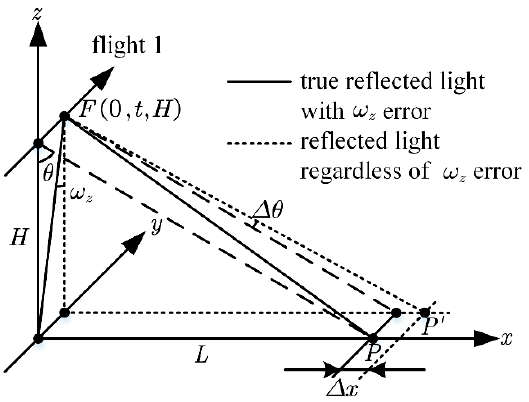
Figure 12. Schematic diagram of the simulation model of ω z .